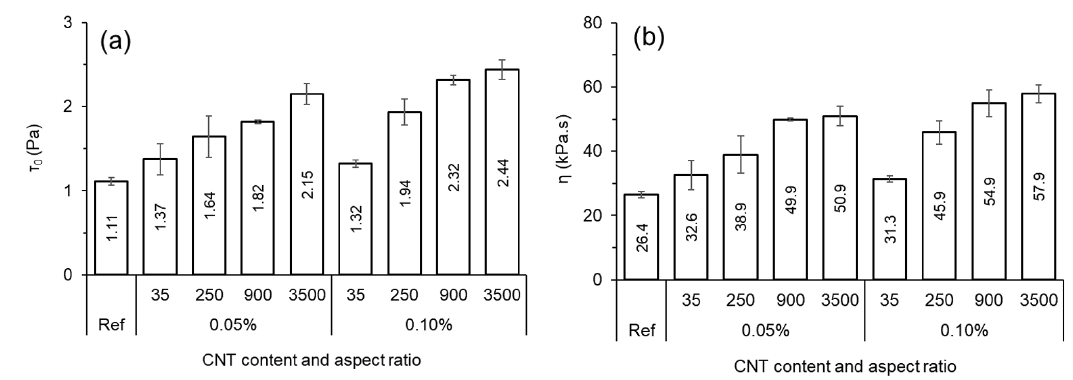
Figure 2. Rheological parameters of the pastes. (a) yield stress; (b)